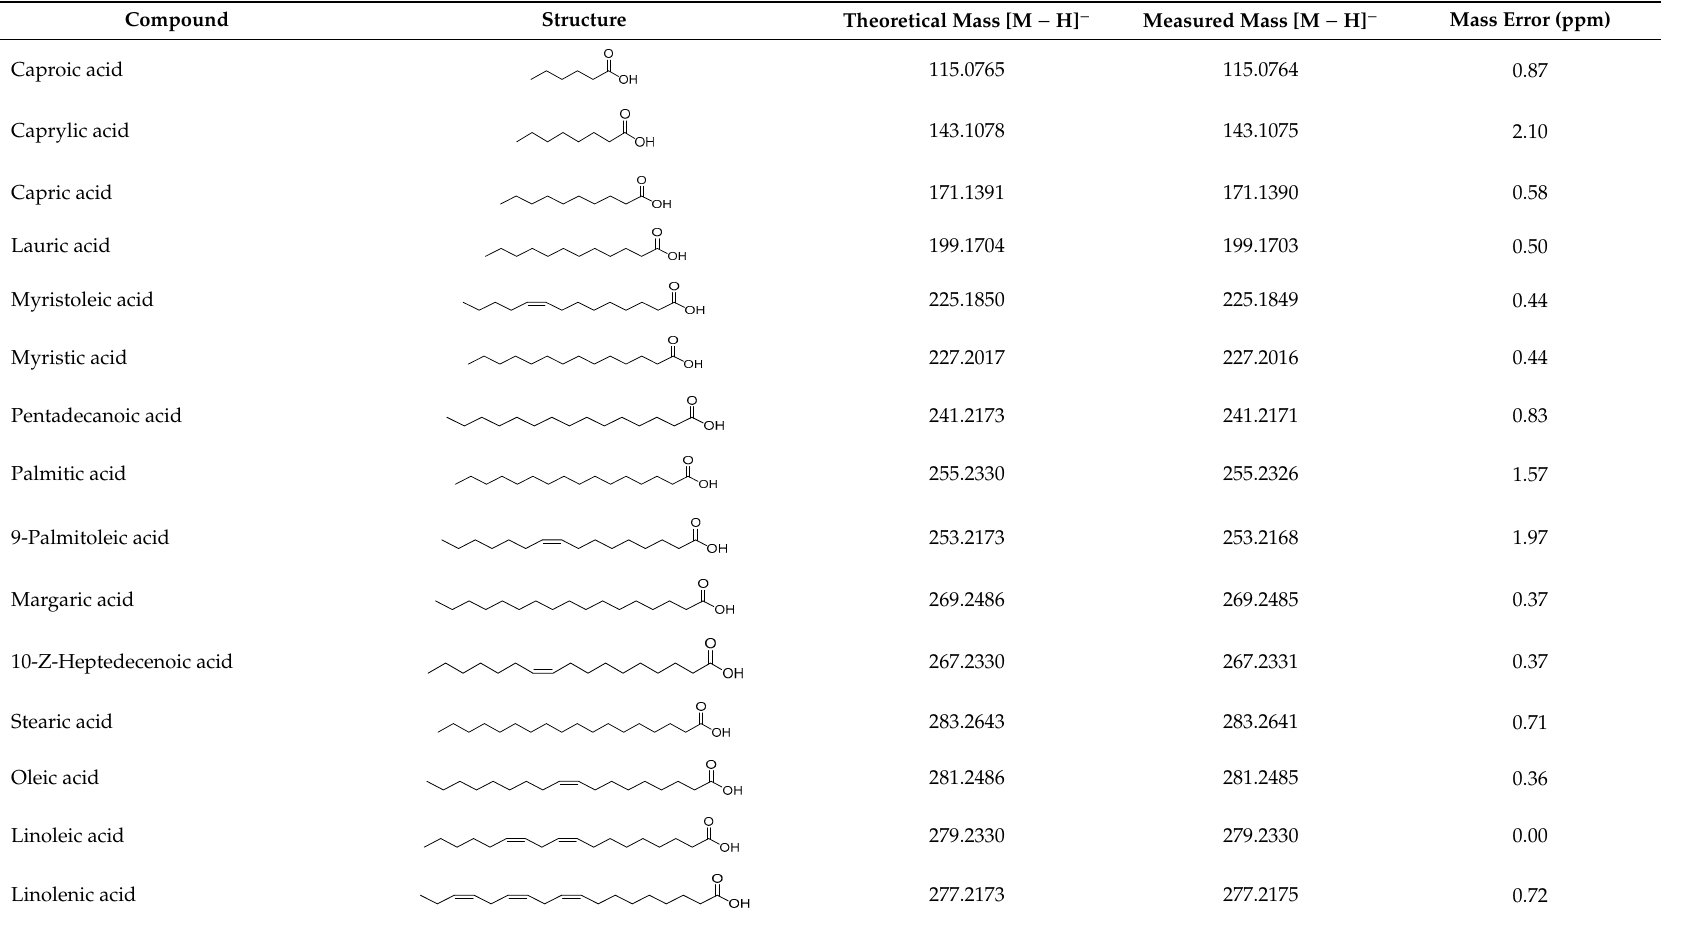
Table 1. Fatty acid standards used in the chromatographic method and mass spectral data.